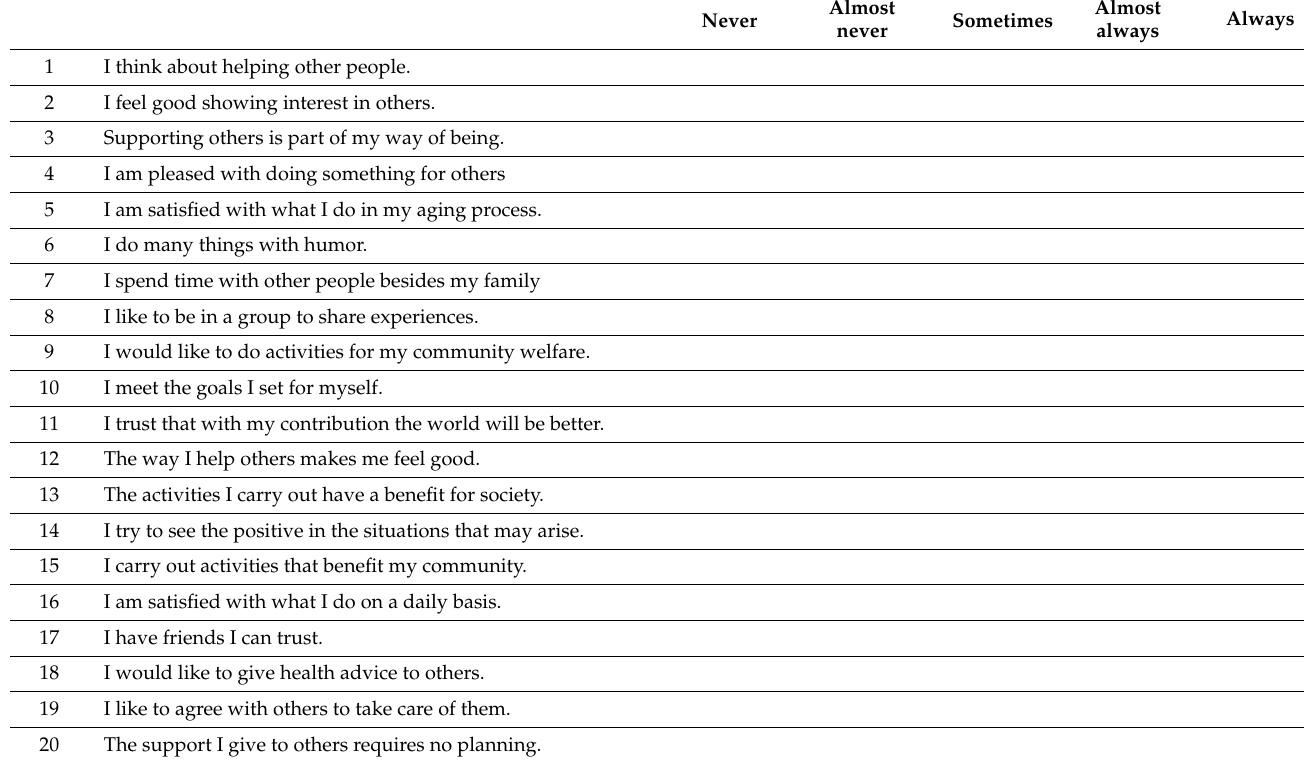
Table A3. Generativity Relative to Health (GeReH) (English version). Below, is a series of statements about what you feel, think or do, please indicate how often you think you carry out each one of them in a range that goes from 1 to 5 considering that: 1 = Never, 2 = Almost never, 3 = Sometimes, 4 = Almost always, and 5 = Always. Your answers are very important, so we ask you to respond truthfully knowing that there are no right or wrong answers and that the information you share